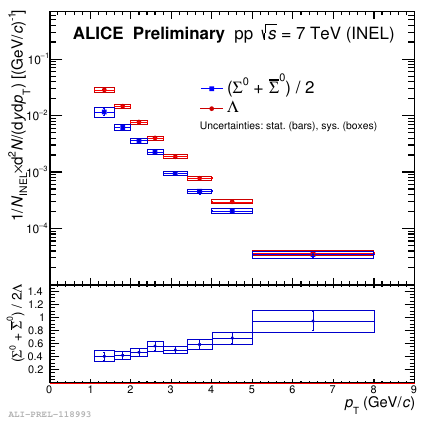
0 ) / 2 and Λ [10] as a function of p T are in the top panel. The 0 ) / 2 to Λ as a function of p T are in the bottom